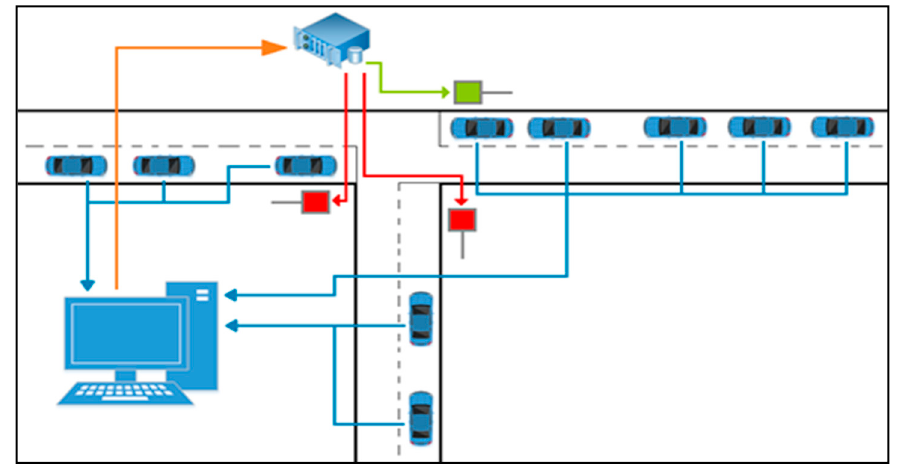
Figure 7. The whole prototypal system for the experiment.